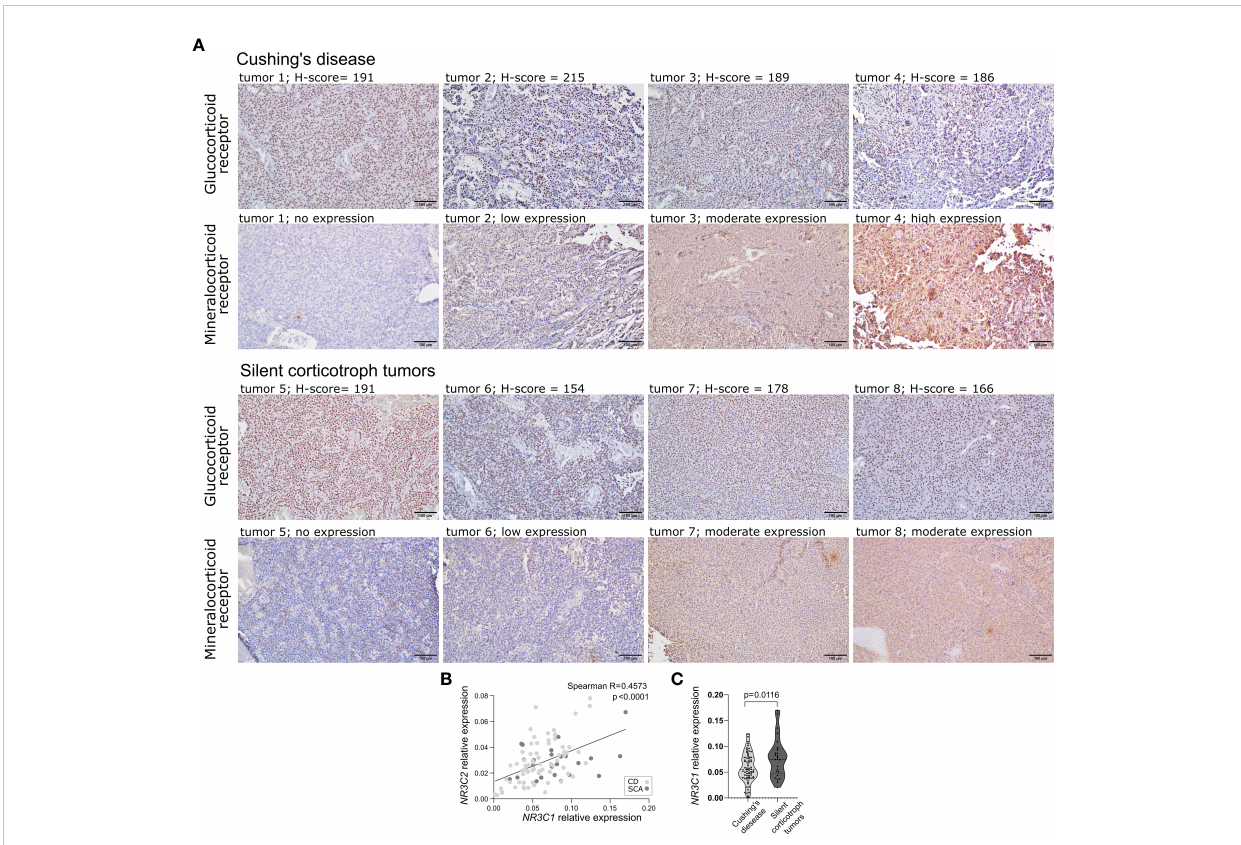
FIGURE 1 The expression of corticosteroid receptors in corticotroph tumors. (A) Representative examples of results of immunohistochemical staining against glucocorticoid receptor and mineralocorticoid receptor. (B) Difference in NR3C1 expression in silent corticotroph pituitary tumors and functioning corticotroph tumors causing Cushing ’ s disease (CD). (C) The correlation between the expression of NR3C1 and NR3C2 in corticotroph